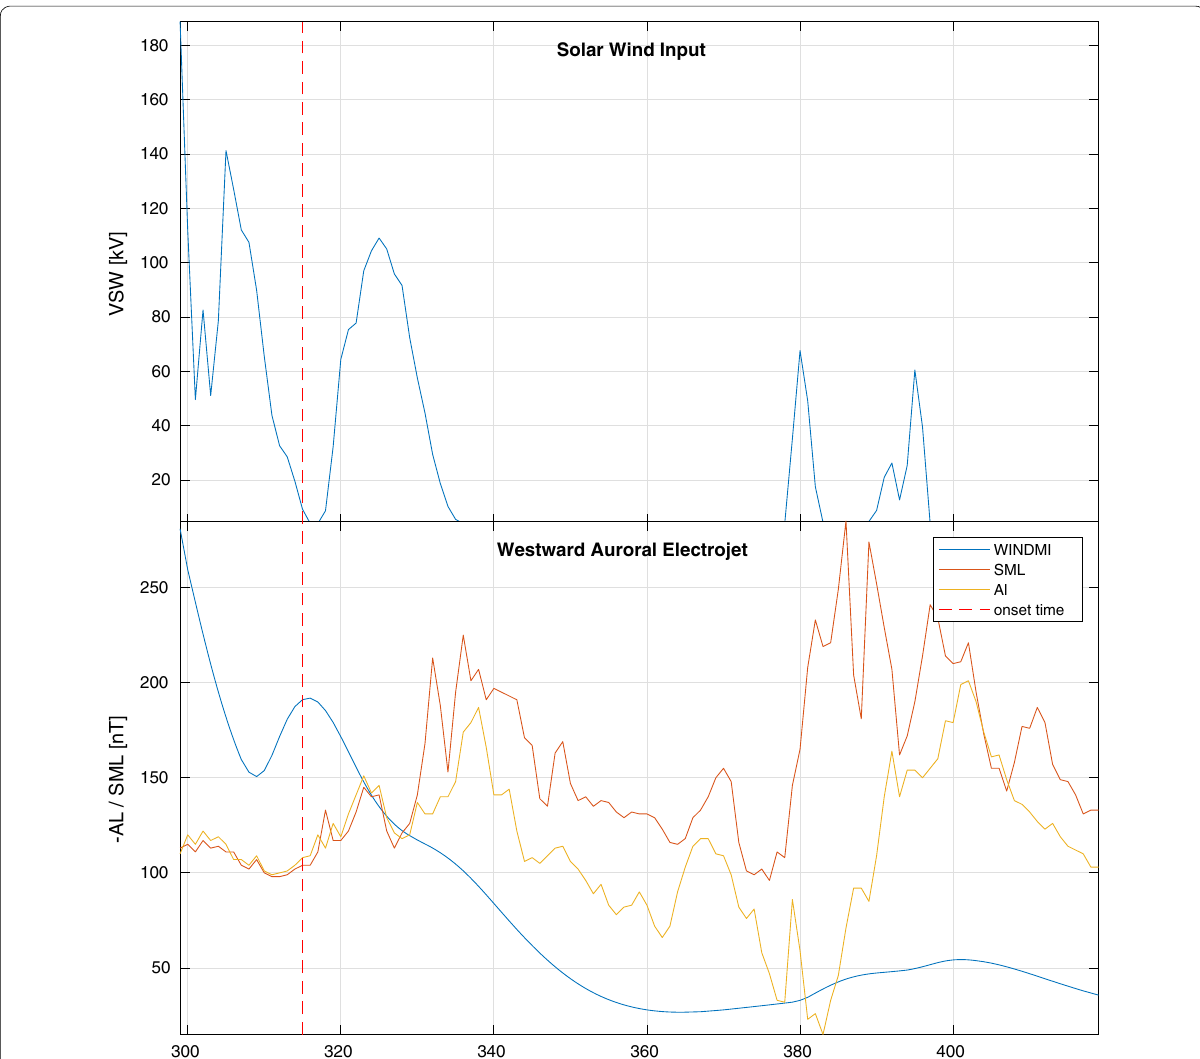
Fig. 4 Event 05:15 UT 07 March 2010: In the bottom panel, substorm onset time from auroral observations is depicted with the red-dotted line. The WINDMI model output is compared to the AL and SML indices. The top panel shows the solar wind input measured by the ACE satellite and propagated to the nose of the